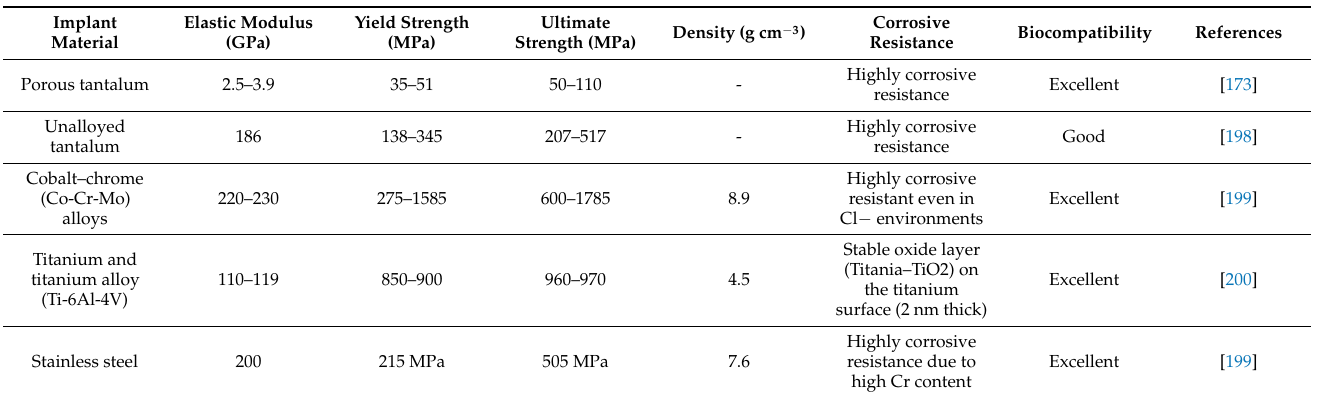
Table 2. Properties of biomaterials used for making orthopedic